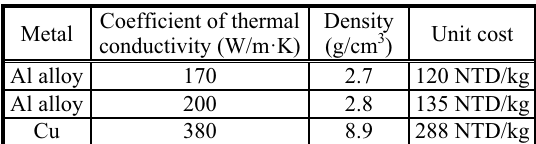
Table 1. Information about the three types of materials considered in this study.